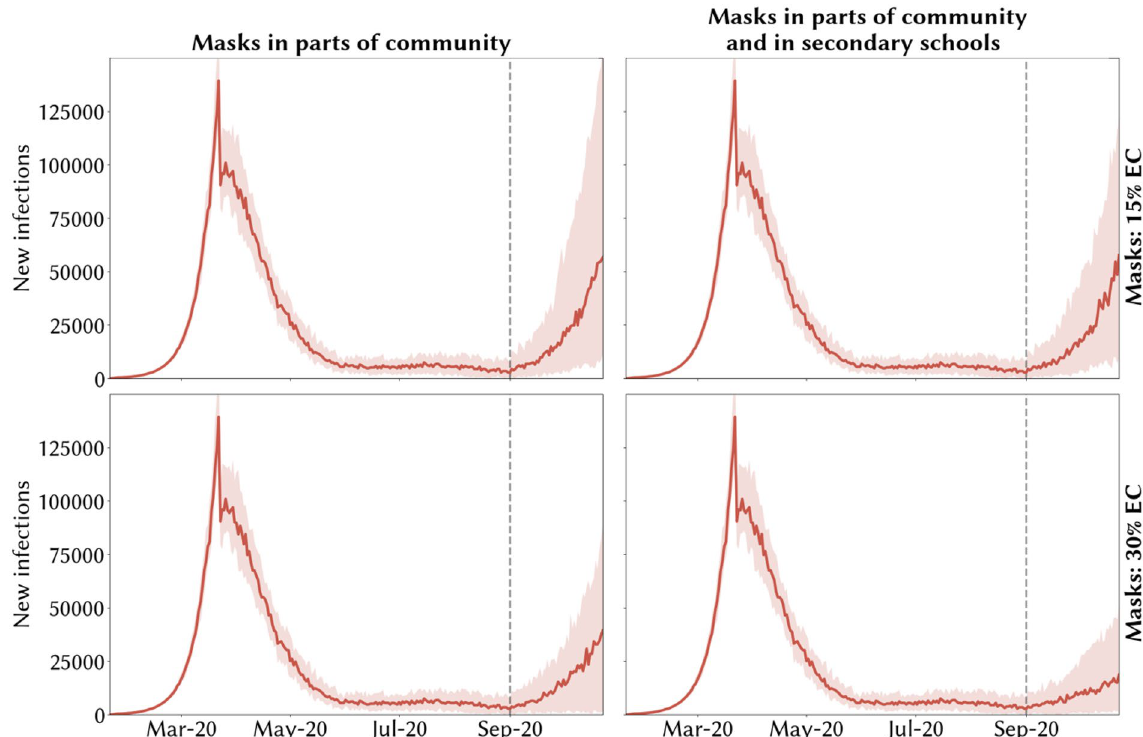
Figure 3. Model scenarios of potential second COVID-19 epidemic wave in the UK during 2020 under different policies of mask wearing and effective coverage, assuming a testing level of 24% and school/workplace tracing levels of 50%. Medians across 30 simulations are indicated by solid red lines and 10% and 90% quantiles by red shading. The resurgence of COVID-19 after September 2020 is controlled and second wave avoided with combinations of adequate test-trace and mask usage if the median number of daily infections remains below 20,000 over the simulation